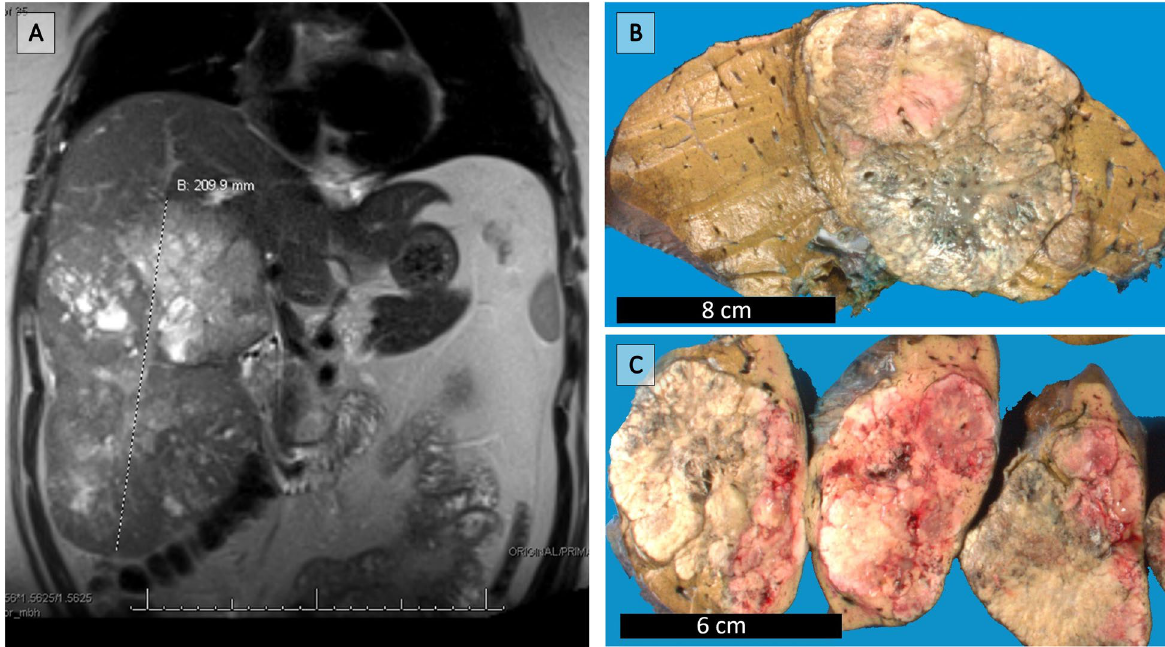
Fig. 1 T2 MRI shows an enlarged liver measuring 29.0 22.0 x 10.0 cm with mass lesion ( A ). Grossly identified are two tan-white to tan-pink, focally × hemorrhagic abutting tumors measuring 21.5 cm and 4.5 cm ( B and C